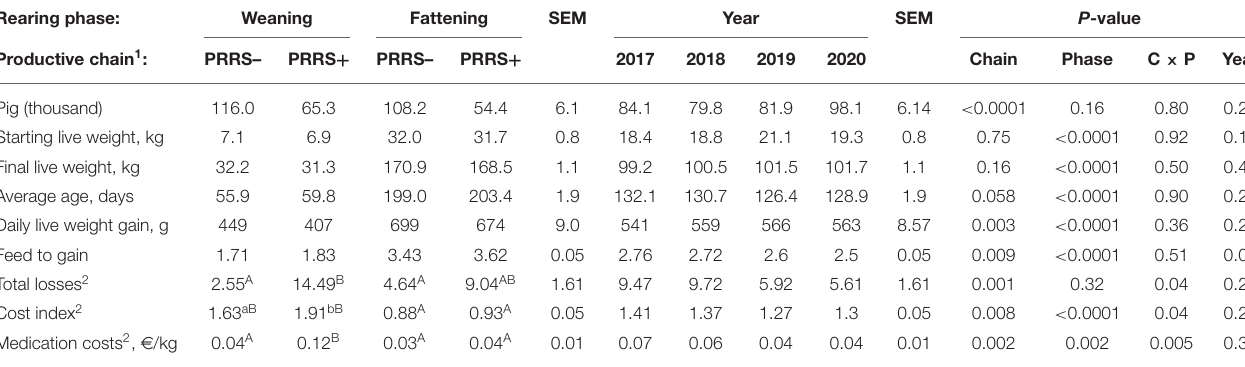
TABLE 1 | General production data in the pig production chains differentiated by the occurrence of porcine reproductive and respiratory syndrome. Rearing phase: Weaning Fattening SEM Year SEM P